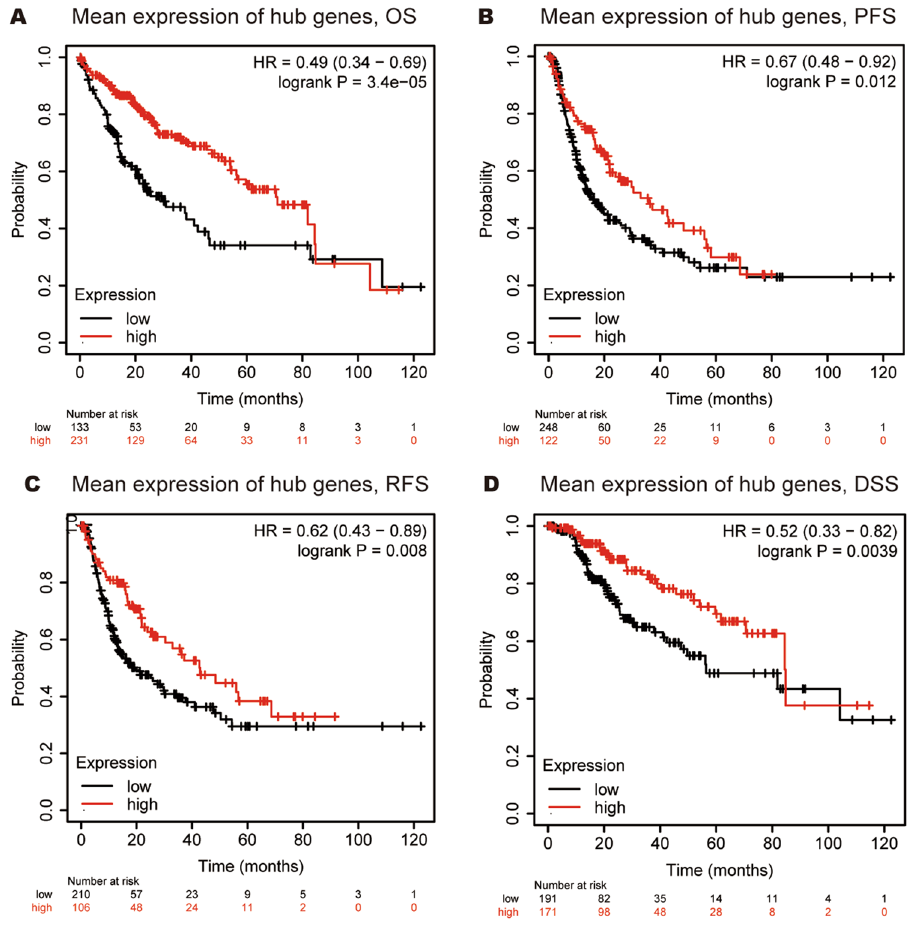
Figure 9. Higher combinatory mRNA expressions of all ten hub genes were associated with better prognosis in HCC. ( A ) OS analysis, ( B ) PFS analysis, ( C ) RFS analysis and ( D ) DSS